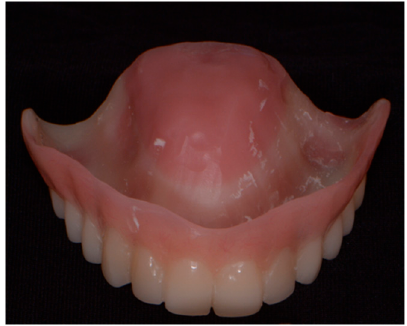
Figure 4. PMMA total provisional prosthetic device.